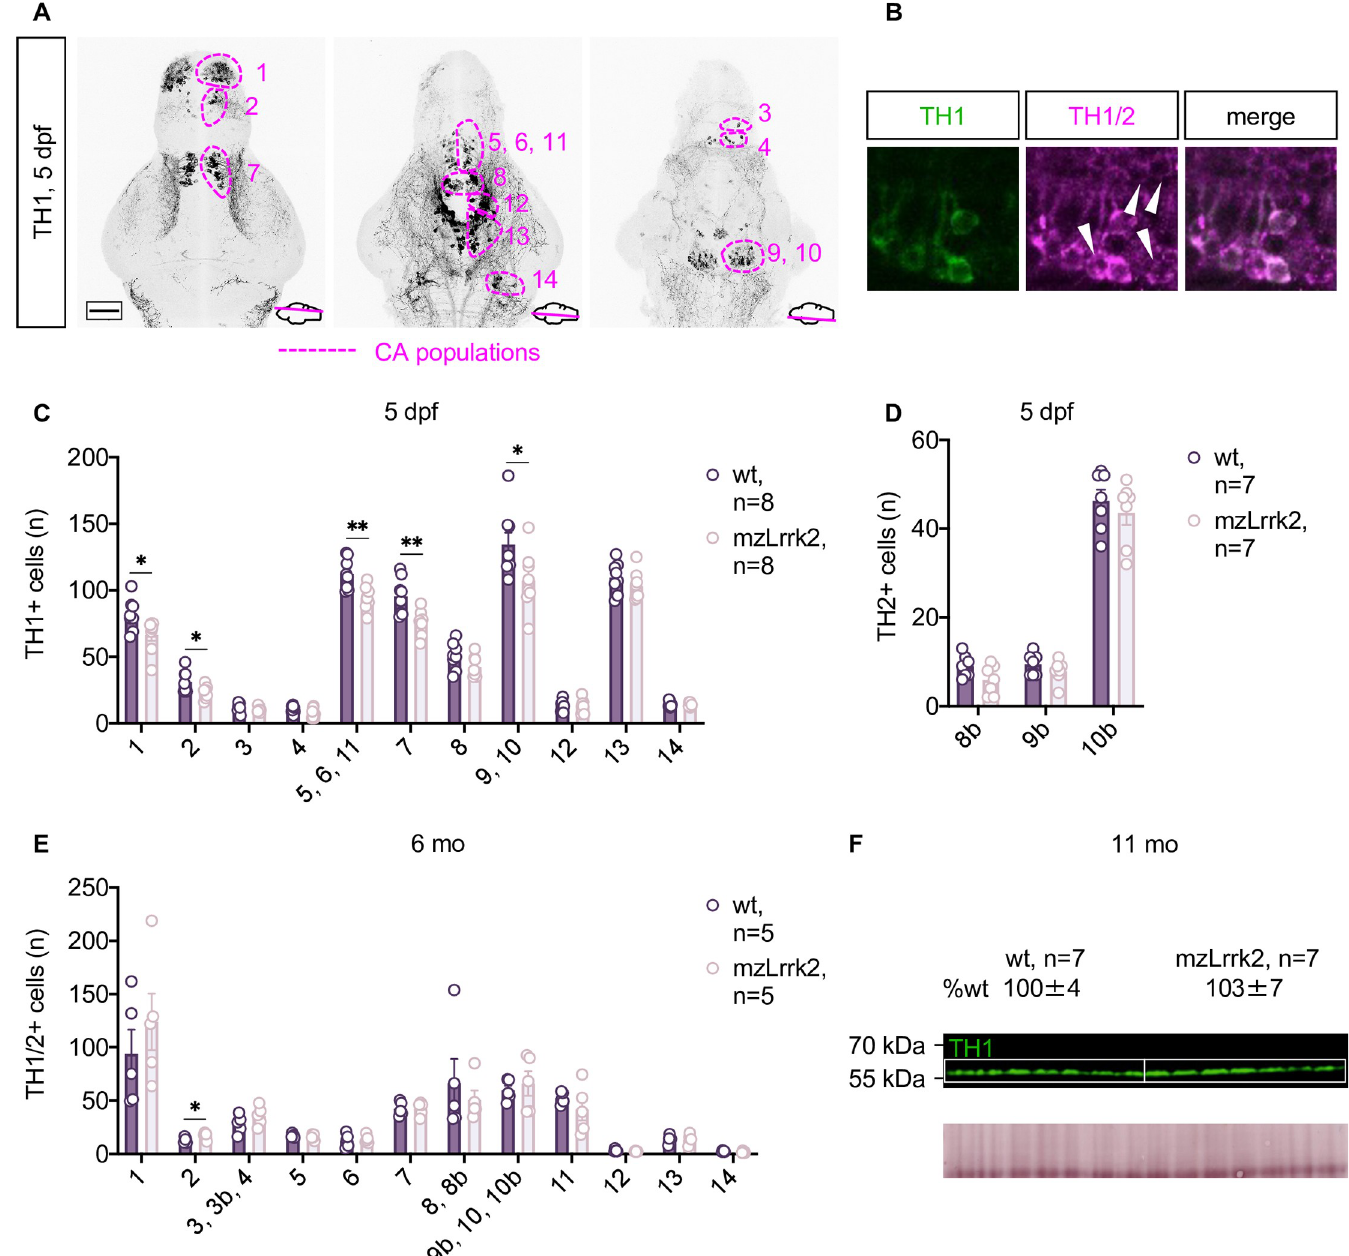
Fig 3. Population-specific defects in the CA system of mzLrrk2 larvae. (A) The zebrafish CA cell populations in the rostro-caudal axis from the olfactory bulb to the locus cæruleus as revealed by tyrosine hydroxylase 1 (TH1) IHC at 5 dpf. Pop. 1: olfactory bulb; pop. 2: telencephalic complex; pop. 3: preoptic area, pars anterior ; pop. 4: preoptic area, pars posterior ; pop. 5, 6, 11: diencephalic complex; pop. 7: pretectal area; pop. 8: paraventricular organ, pars anterior ; pop. 9: paraventricular organ, pars intermedia ; pop. 10: paraventricular organ, pars posterior ; pop. 12: posterior tuberal nucleus/posterior tuberculum; pop. 13: hypothalamic complex; pop. 14: locus cæruleus . (B) Combination of the anti-TH1 antibody with the pan-TH antibody allows the identification of TH2+ cells (white arrowheads) by exclusion. TH2+ cells are found within the TH1 pop. 8, 9, and 10 in the paraventricular organ, thereby constituting the TH2 pop. 8b, 9b, 10b. (C and D) Quantification of TH1+ (C) and TH2 + cells (D) revealed defects in distinct CA cell populations in the brain of mzLrrk2 larvae (5 dpf). Plot represents means ± s.e.m. Statistical analyses: (C: pop. 2–14 and D) two-tailed Student’s t -test; (C: pop. 1) two-tailed Mann-Whitney’s U -test. (E) Quantification of TH1/2+ cells in the adult brain (6 mo) revealed absence of CA cell defects in mzLrrk2 fish. Plot represents means ± s.e.m. Statistical analyses: (E: pop.1, E: pop. 3–11, E: pop. 13 and E: pop. 14) two-tailed Student’s t -test; (E: pop. 2 and E: pop. 12) two-tailed Mann-Whitney’s U -test. (F) Quantification of TH1 protein levels in 11-mo brains shows intact CA system in adult fish; total protein stain as loading control is shown. Protein levels are reported as means ± s.e.m. relative to wt levels (%). Statistical analysis: two-tailed Student’s t -test.